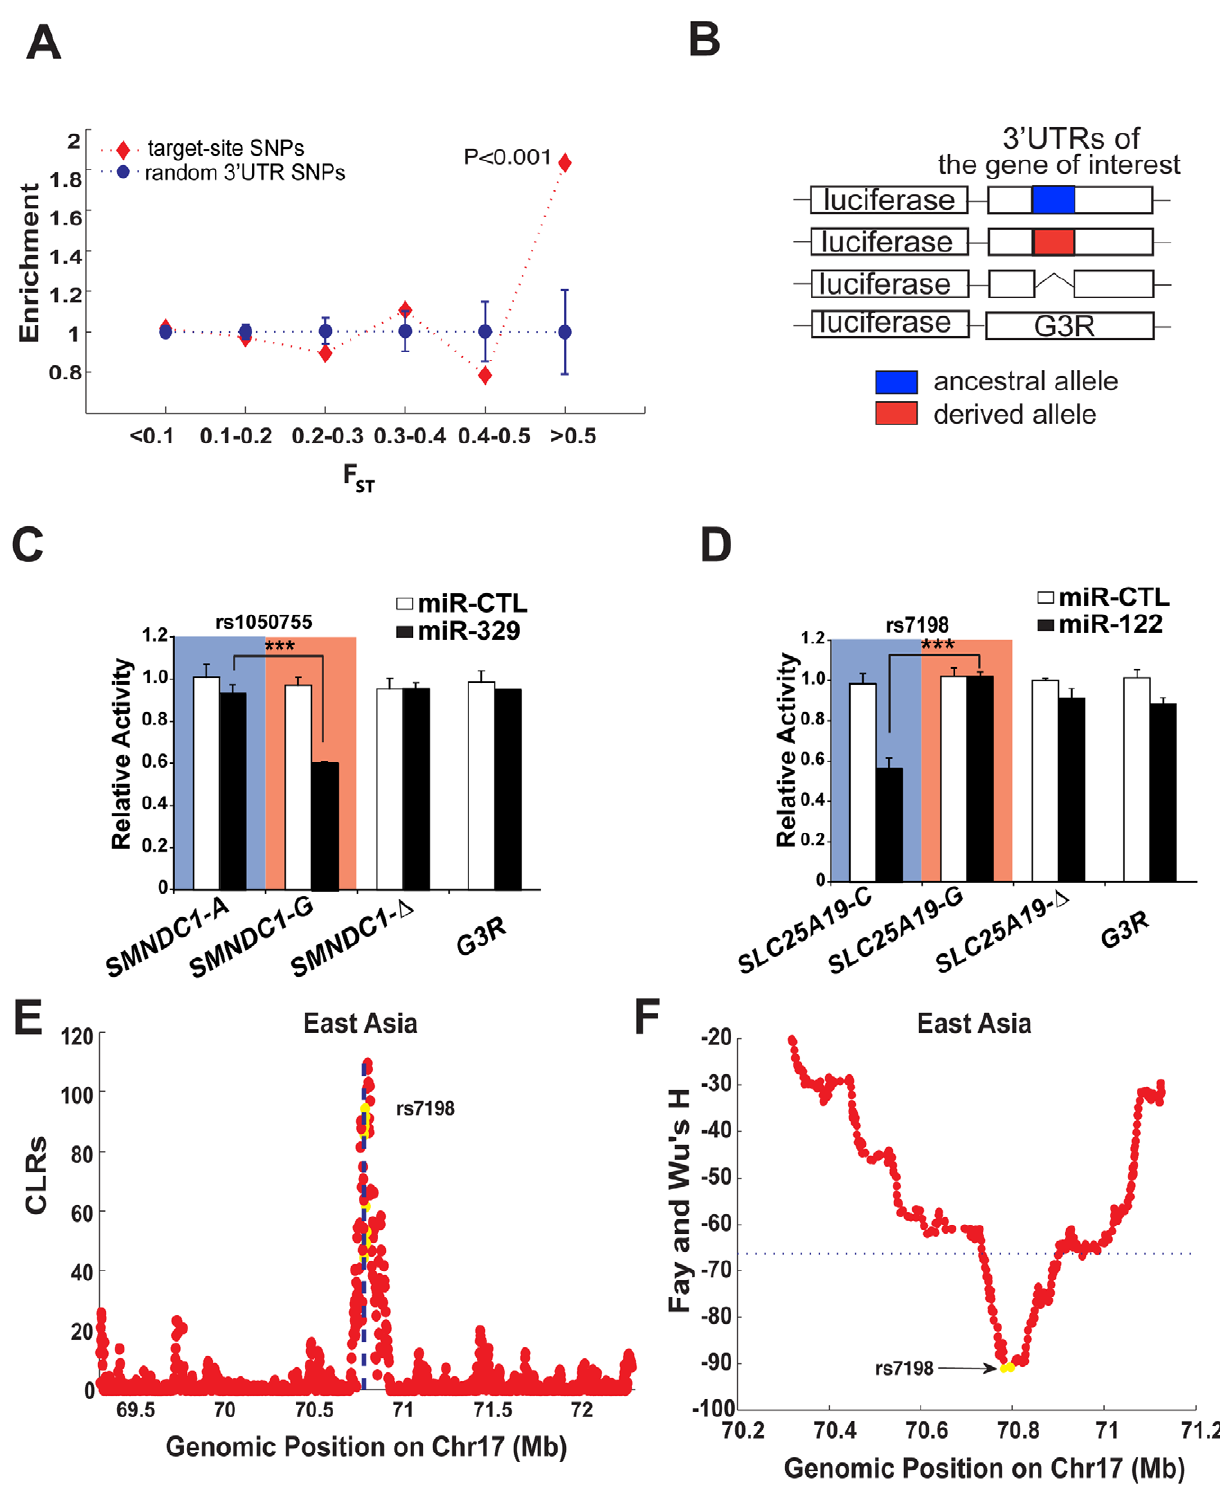
Figure 1. Identification of miRNA binding sites that show extreme population differentiation. (A) The predicted miRNA binding sites are significantly enriched among the High- F ST loci on 3 9 UTRs. The enrichment score was the fraction of the target-site SNPs in each bin divided by the fraction of all the 3 9 UTR SNPs in the same bin. Likewise the enrichment score for the randomly sampled SNPs in each bin was computed in the same way based on 1, 000 bootstrap resampling from all the 3 9 UTR background SNPs. Error bar represents one standard deviation. (B–D) In vitro validation of the predicted miRNA binding sites showing extreme population differentiation. The 3 9 UTR of genes selected for validation were cloned into the pMIR-REPORTER vector. Variants of each gene harbouring the ancestral (blue), derived (red) alleles or a deletion of putative miRNA site were generated and analyzed along with the G3R control vector (B). For analysis of miRNA targeting, the reporters containing the indicated ancestral (blue shading) or derived (red shading) alleles of SMNDC1 (C) or SLC25A19 (D), as well as the deletants or the G3R control were transfected into HEK293T